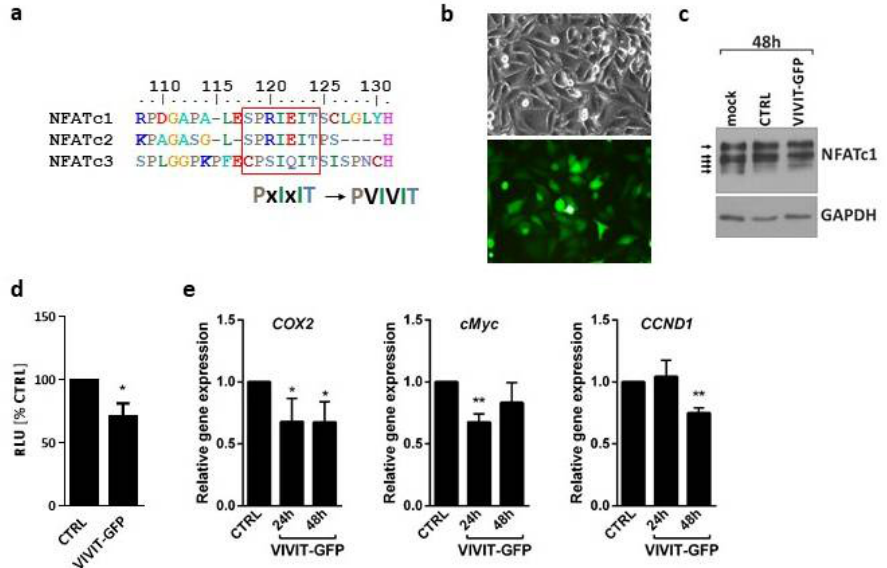
Figure 2. Overexpression of VIVIT-GFP blocks NFAT activity in glioma cells. ( a ) Sequences of calcineurin docking site in NFATc1, NFATc2 and NFATc3 and VIVIT. ( b ) Microphotographs of LN229 cells 48 h after transfection with VIVIT-GFP construct in phase-contrast and fluorescence microscope (upper/lower panel, respectively). ( c ) Western blot analysis of NFATc1 levels in mock transfected LN229 cells and in cells transfected with a control vector (CTRL) or VIVIT-GFP. GAPDH detection was used as a loading control. ( d , e ) Changes in the transcriptional activity of NFAT factors in VIVIT-GFP-transfected cells. Transcriptional activity of NFAT proteins was analyzed by luciferase reporter assay using pGL3-3xNFAT-luc plasmid ( d ) or by qPCR ( e ) to measure mRNA levels of endogenous NFAT target genes at indicated time points. Statistical significance of changes vs. CTRL was determined using one sample t -test (* p < 0.05, ** p < 0.01 ).